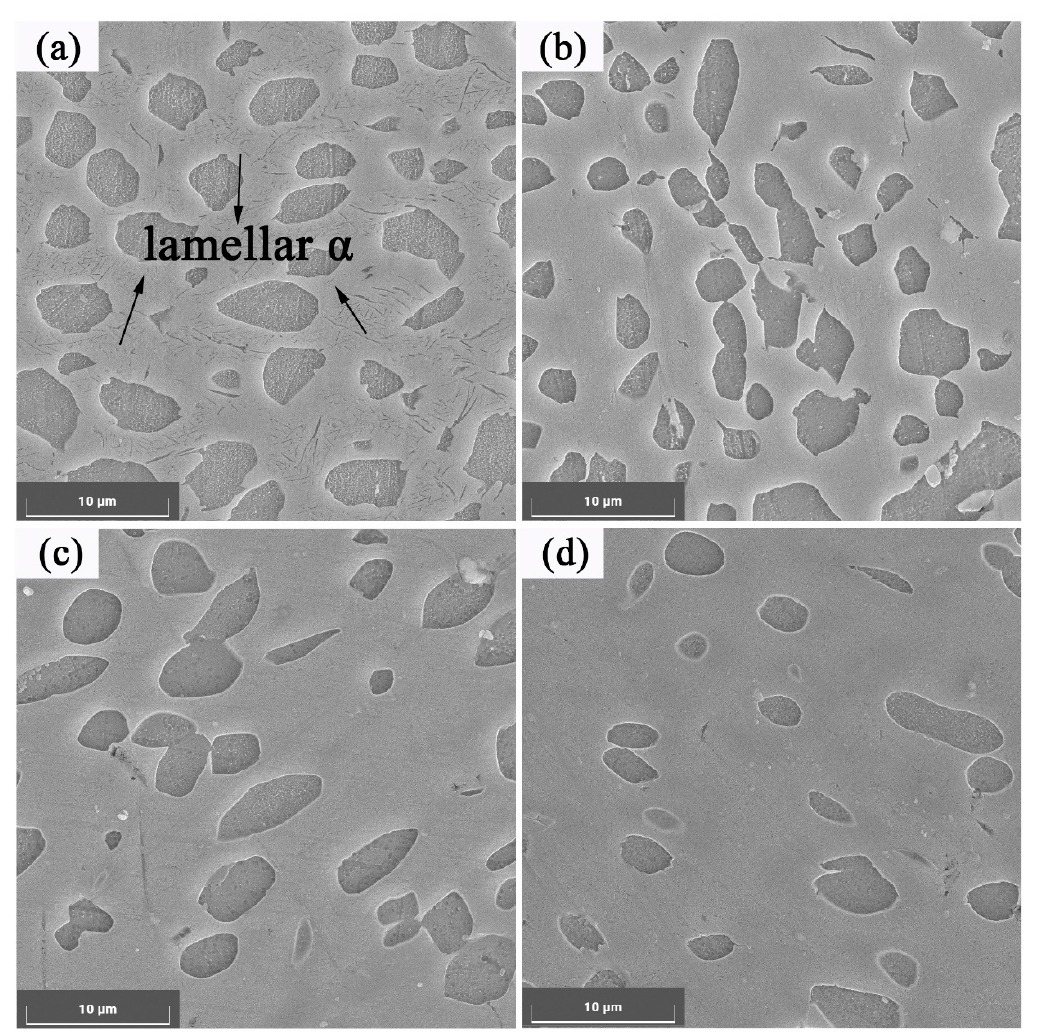
Figure 4. SEM figures after first-pass compression at ( a ) 700 °C, ( b ) 750 °C, ( c ) 800 °C, ( d ) 850 °C.